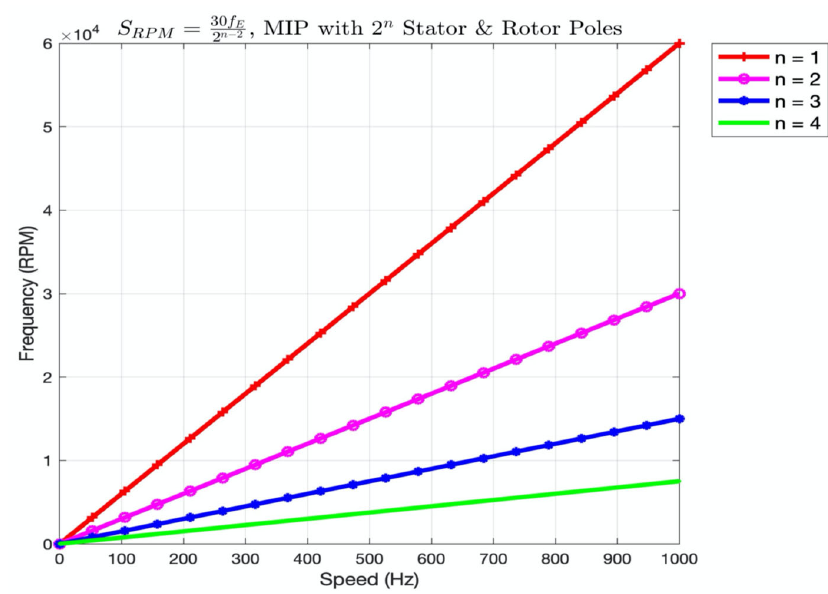
Figure 4. Speed with respect to electrical